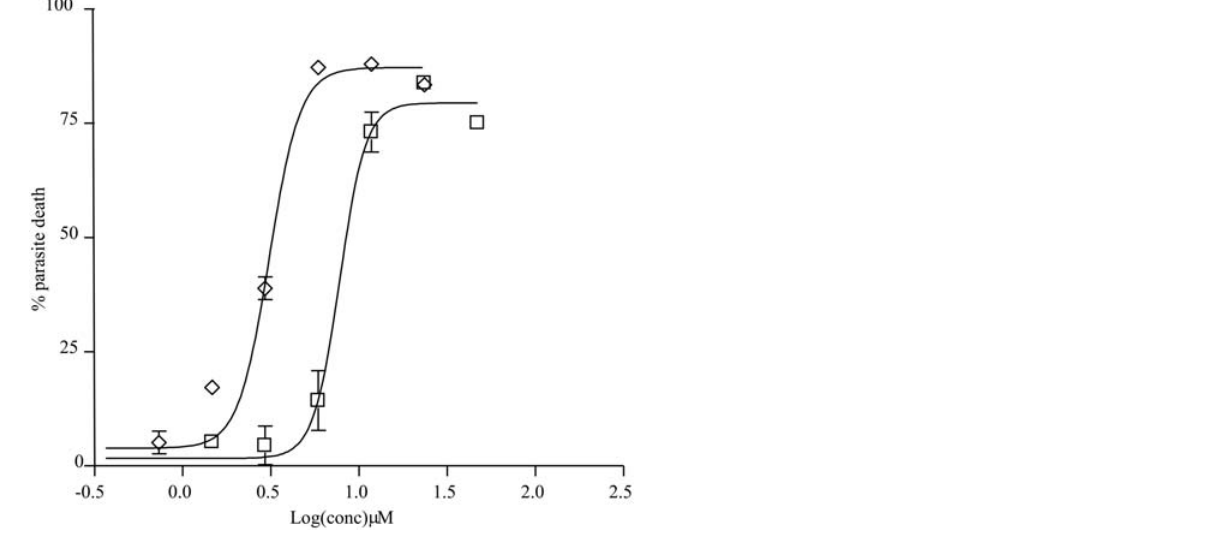
Figure 3. Dose response curves for 1 (diamonds) and 2 (squares) in the assay with amastigote-like forms of L.amazonensis . The EC 50 (effective concentration to kill 50% of the parasites) values were found to be 1.7 m M (95% confidence interval=1.5 to 1.9 m M) and 4.1 m M (95% confidence interval=3.6 to 4.7 m M), respectively. The data in the plots are derived from at least two independent experiments.